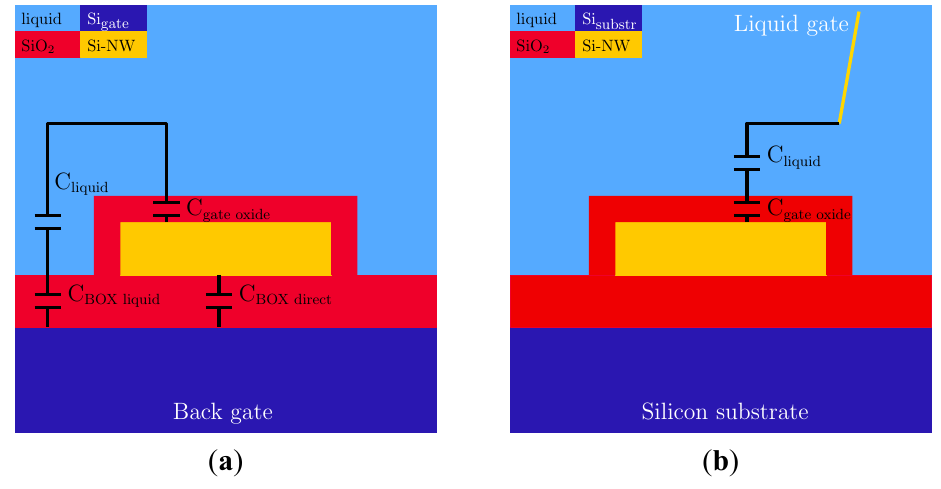
have much influence on the characteristics of the device compared to the LG only (blue circles vs. green triangles). Figure 2. Schematic representations (not to scale) of the coupling of the potential when applying the potential to ( a ) the back gate and ( b ) the liquid gate.